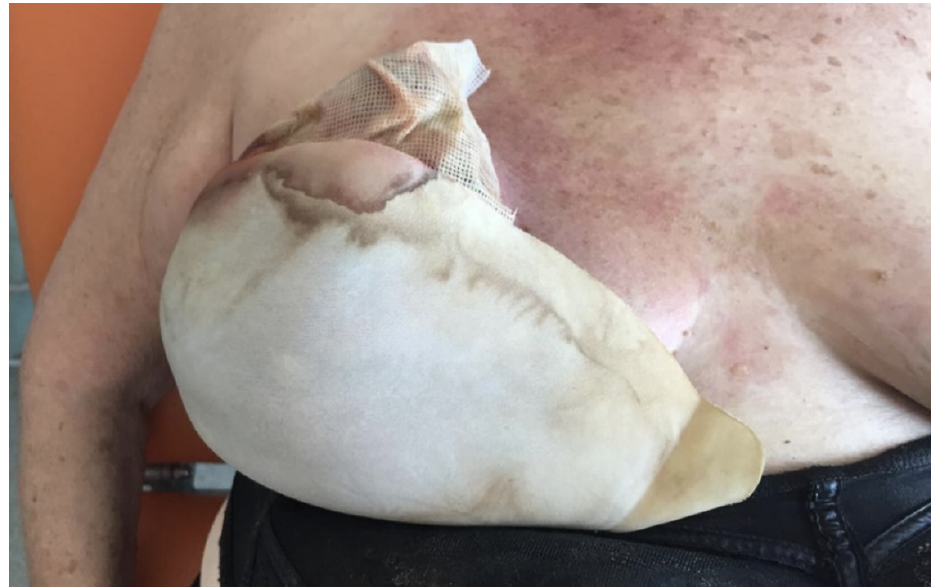
Figure 2. The device is applied to cover all the breast.